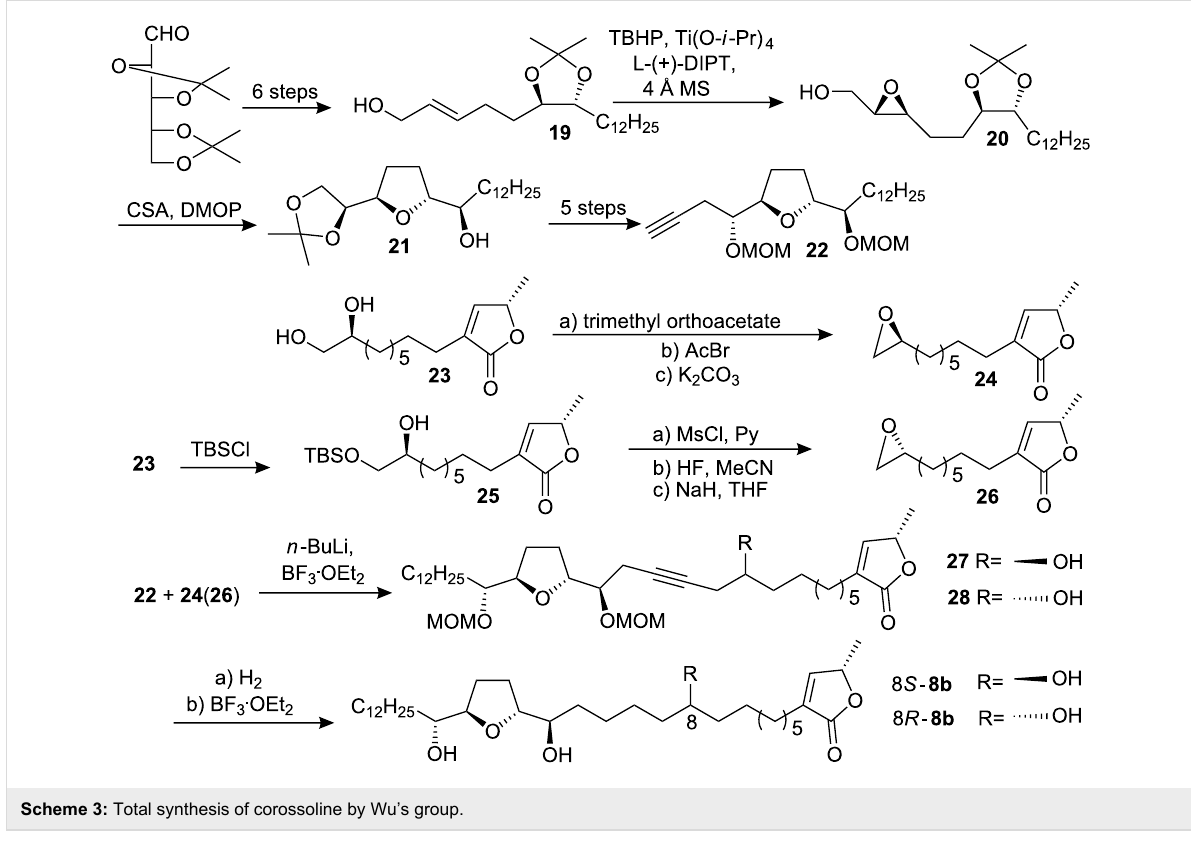
Scheme 3: Total synthesis of corossoline by Wu’s group.